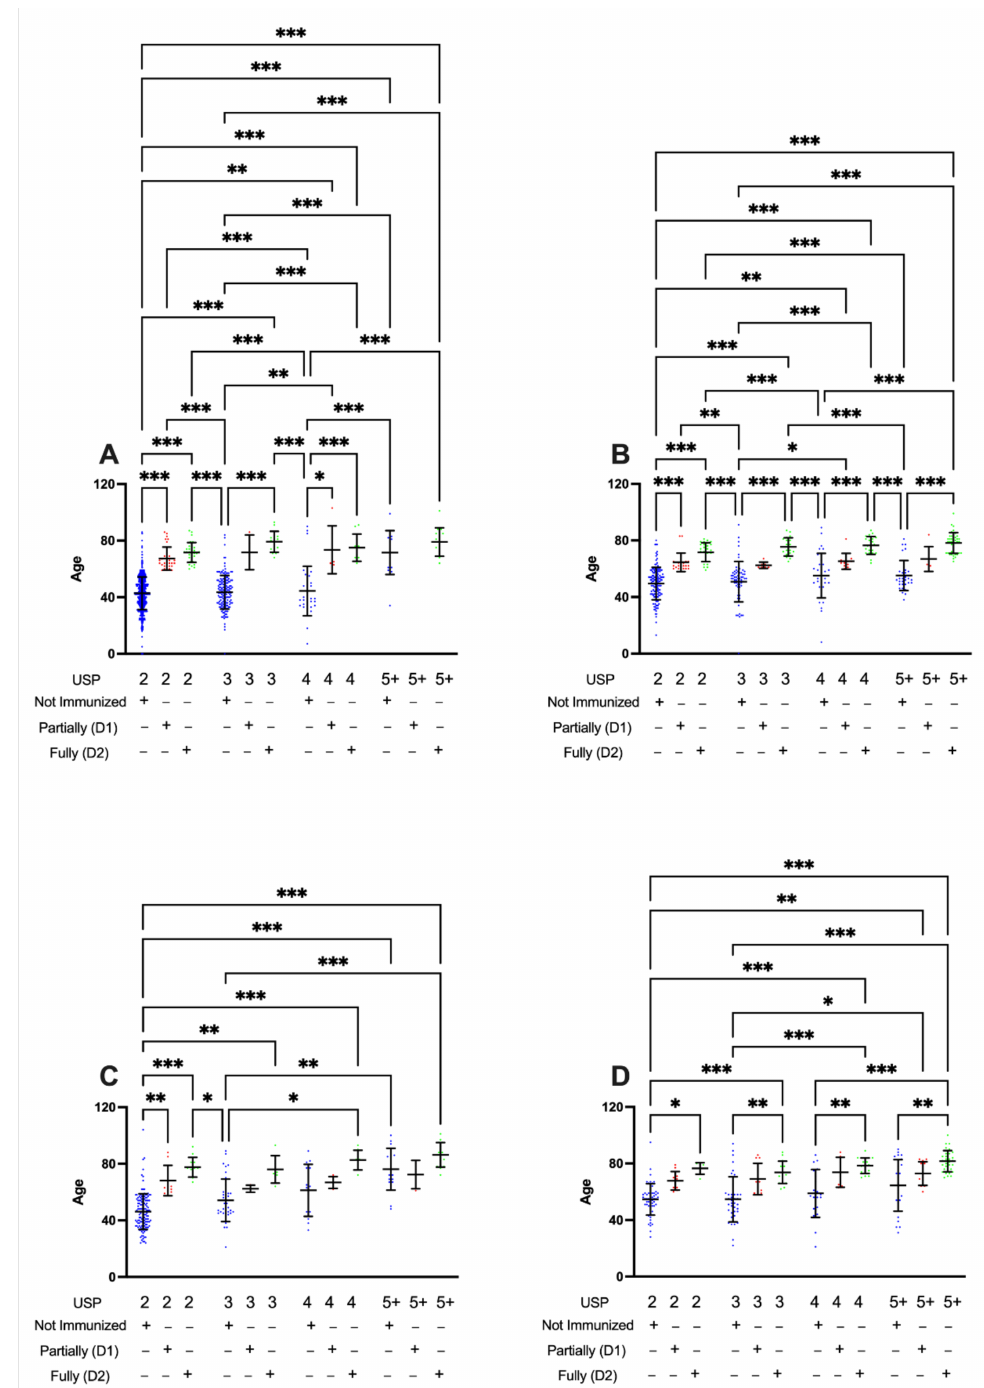
Figure 4. Profile of hospitalization post-vaccination and their influence on the Unified Score for Prioritization (USP). Patients between June and August 2021 were grouped according to their out- come, immunization status, and the existence of comorbidities. ( A ) Discharged patients without comorbidities; ( B ) Discharged patients with comorbidities; ( C ) Lethal cases without comorbidities; ( D ) Lethal cases with comorbidities. The statistical analysis was performed using the Kruskal–Wallis test for group comparison and Dunn’s test to perform multiple comparisons. The results are shown as the mean ± standard deviation (* p < 0.05; ** p < 0.005; *** p <